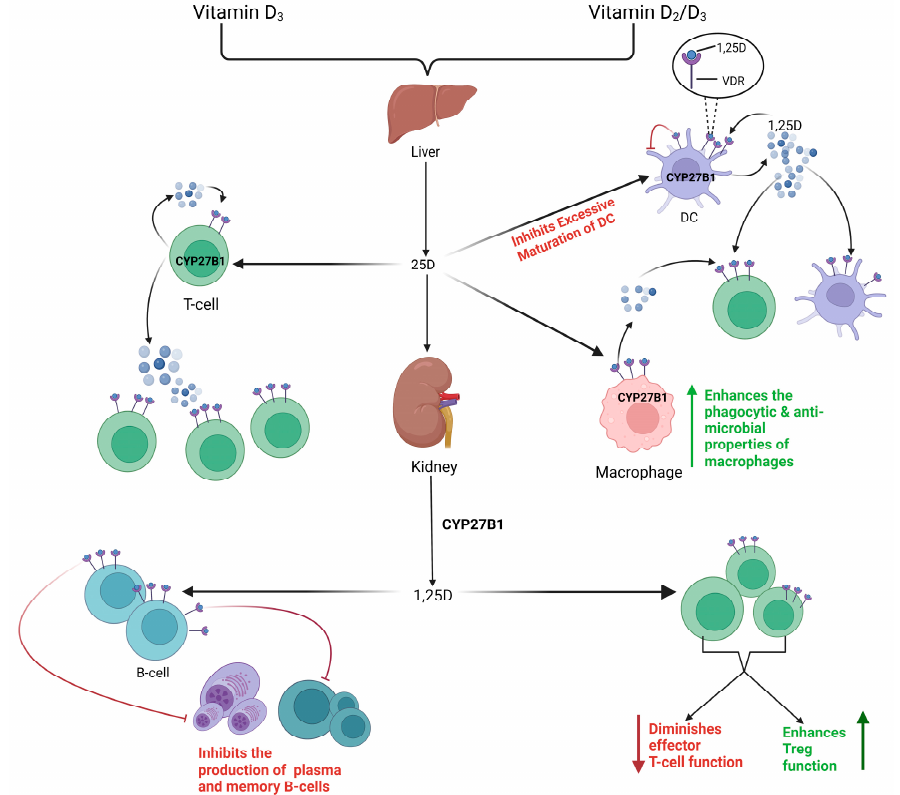
Figure 4. Vitamin D receptors (VDR) and CYP27B1 are expressed in immune cells and regulate immune responses. The presence of CYP27B1 in antigen-presenting cells (APCs), T cells, B cells, and monocytes allows these immune cells to produce 1,25D, which can bind to its receptor VDR. The 1,25D-VDR complex inhibits the excessive maturation of dendritic cells (DCs). In monocytes and macrophages, 1,25D boosts their phagocytic capabilities and antimicrobial effects. 1,25D contribute to B-cell homeostasis by directly inhibiting memory and plasma cell generation. Furthermore, different forms of vitamin D can affect the proliferation and differentiation of T cells, such as the intracrine conversion of 25D to 1,25D by T cells. T cells may also be affected downstream of the production of 1,25D in APCs and macrophages. 1,25D can elevate the levels of circulating Tregs and reduce the effector functions of cytotoxic and helper T cells, which supports tolerance and highlights its anti-inflammatory properties.